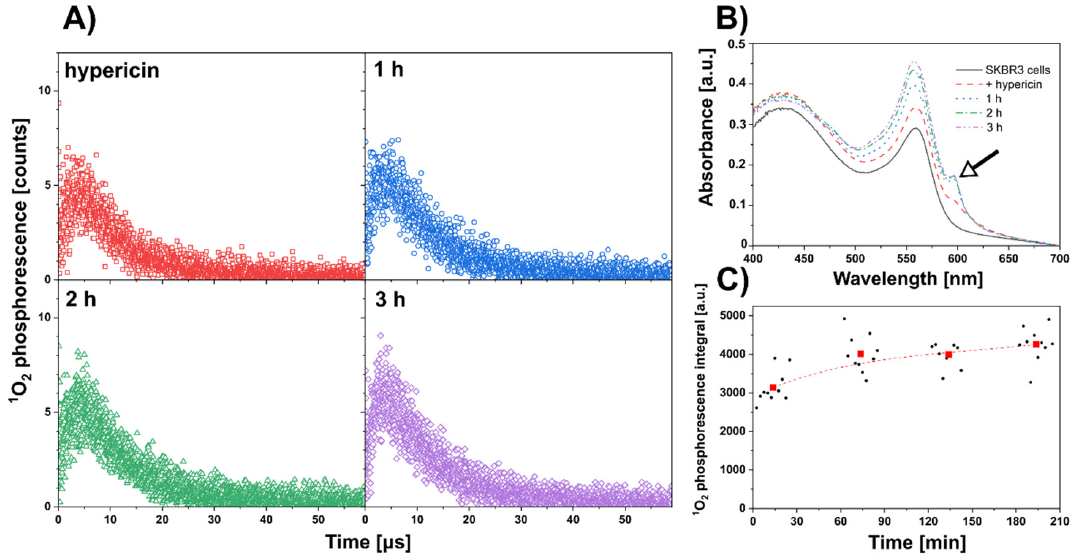
Figure 3. ( A ) Singlet oxygen ( 1 O 2 ) phosphorescence produced in the solution of 5 µM hypericin and SKBR3 cells measured immediately (red), 1 h (blue), 2 h (green), and 3 h (violet) after hypericin administration. ( B ) Absorbance spectra of SKBR3 cells detected before (black), immediately (red), 1 h (blue), 2 h (green), and 3 h (violet) after hypericin administration. Black arrow indicates hypericin absorption. ( C ) Integral of 1 O 2 phosphorescence determined at each acquisition point (black circles– particular values, red square–average of 10 particular values). The experiments were repeated at least twice.